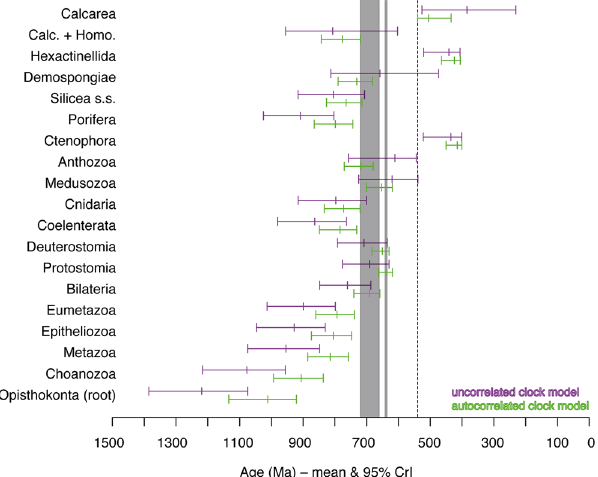
Figure 1. Age estimates for major animal groups obtained under different molecular clock models. Mean and 95% credibility intervals (CrIs) of age estimates for select nodes obtained with Calibration set A and the 1000 Ma root age prior (see text) under the autocorrelated “ln” (lower bars) and uncorrelated “ugam” (upper bars) relaxed clock models. Taxon names refer to crown groups. “Calc. + Homo.” = Calcarea + Homoscleromorpha clade. Ma = million years before present. Dotted line indicates Precambrian/Cambrian boundary. Gray areas indicate Sturtian (left) and Marinoan (right) glaciations 21